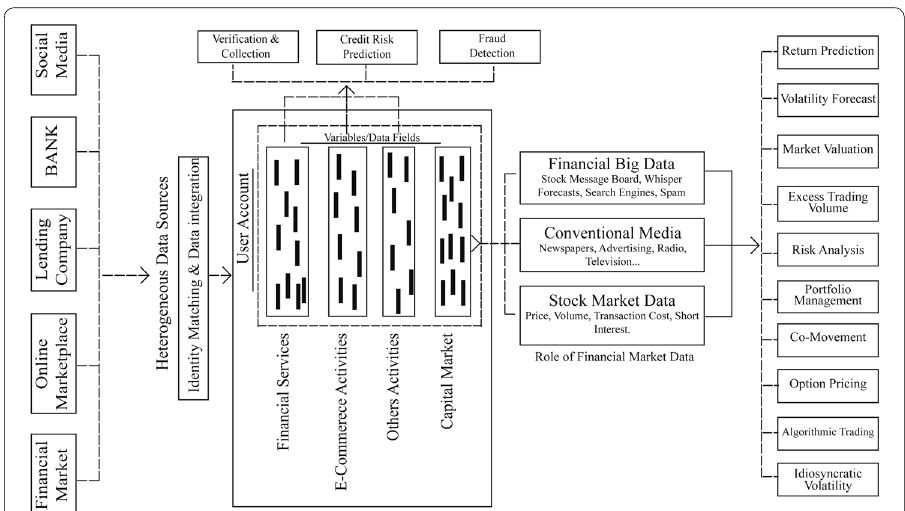
Fig. 2 Theoretical framework of big data in financial services. Source: Author’s explanation. (This concept of this framework has been taken from Shen and Chen [71] and Zhang et al.